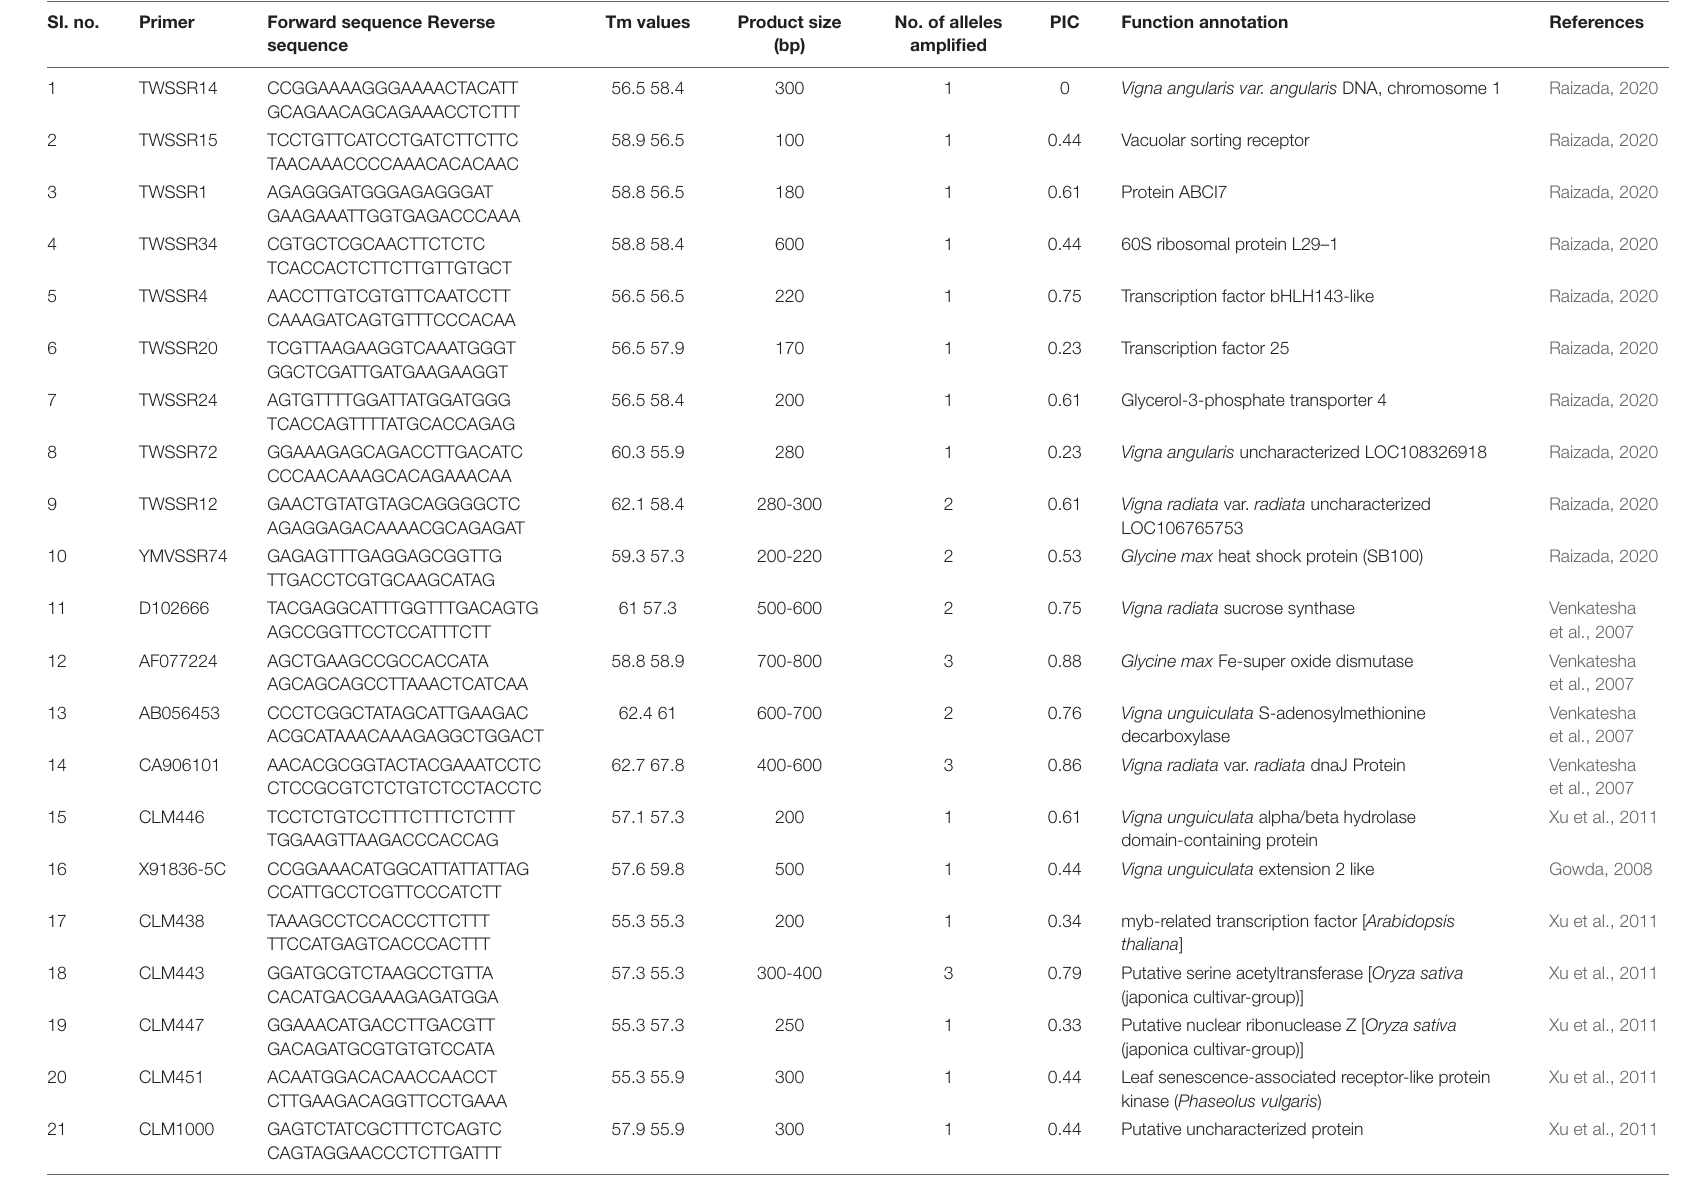
TABLE 13 | Details of genic-SSRs used for genotyping 16 urdbean genotypes. SI. no.